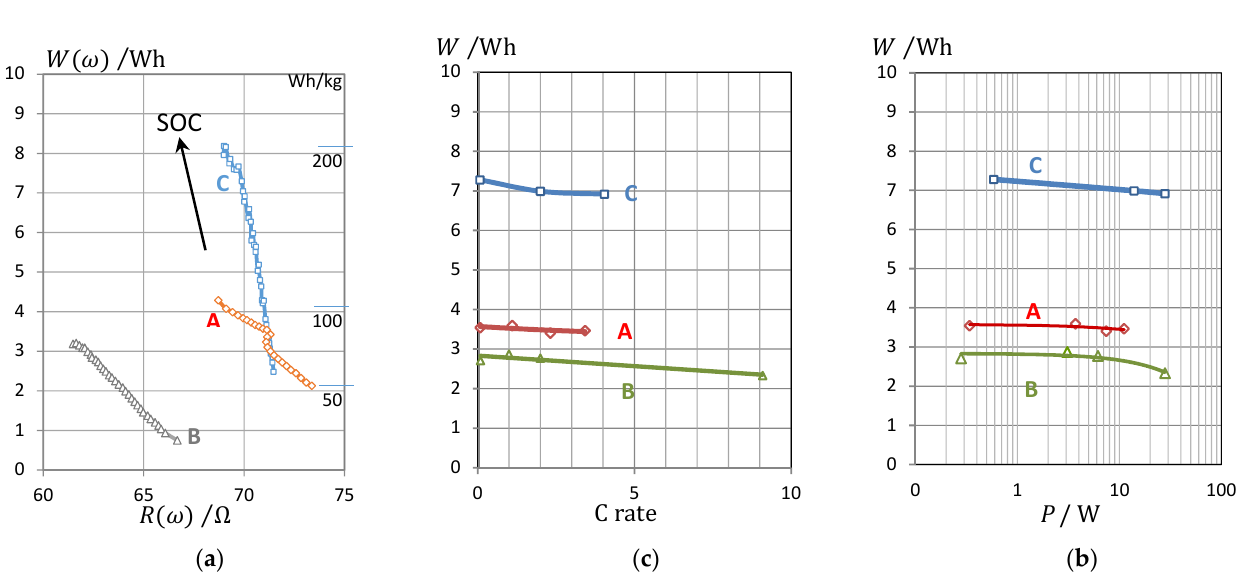
Figure 7. ( a ) Energy W of three types of LFP cells determined by the pseudocharge Q = C U at 0.15 Hz against the real part of impedance (ohmic resistance) at 0.15 Hz. A VoltSolar 3.2 V/1.4 Ah, B Sony 3.2 V/1.1 Ah, C LithiumWerks 3.3 V/2.6 Ah. ( b ) For comparison: Peukert diagram of true energy versus C rate, ( c ) Ragone plot: true energy versus power (measured by current and voltage).